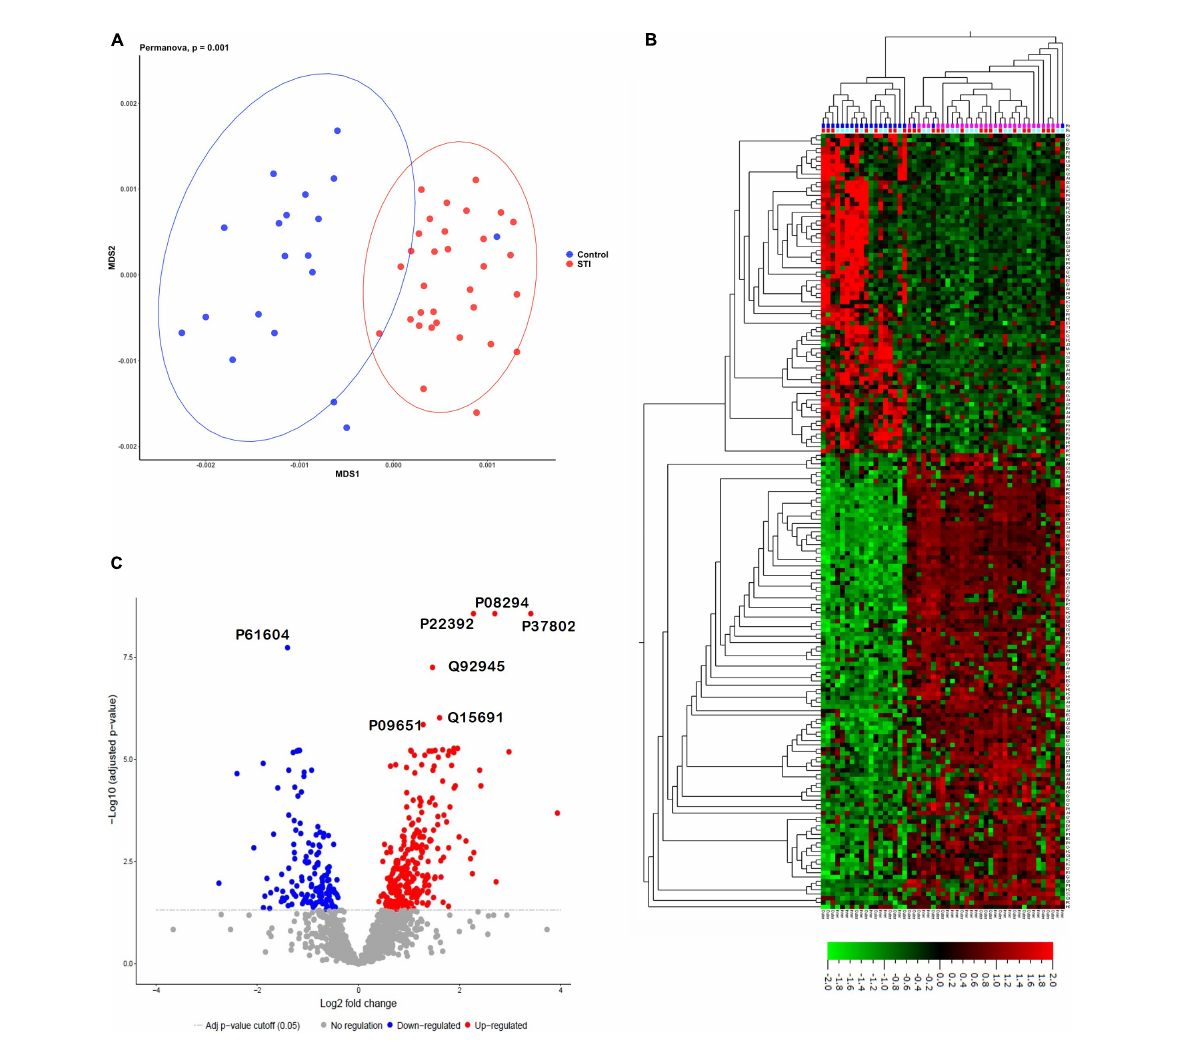
FIGURE2 Distinct proteomes of inner and outer foreskins from men with aSTI compared to age-matched controls without aSTI. (A) MDS plot showing dissimilarity of proteomes in aSTI foreskins compared to controls, (B) volcano plot showing 400 significantly up- or downregulated proteins (adjusted p = 0.05) comparing differences in log 2 fold changes between control (STI) and aSTI foreskin protein expression. Gray dots indicate non-significant protein fold changes, blue dots represent proteins with a negative log 2 fold change (higher expression in STI samples), and red dots depict those with a positive log 2 fold change (higher expression in aSTI samples). (C) Unsupervised hierarchical clustering showing differential protein expression of fold changes in the expression of the foreskin proteins in control samples and aSTI foreskins ( q = 0.01).